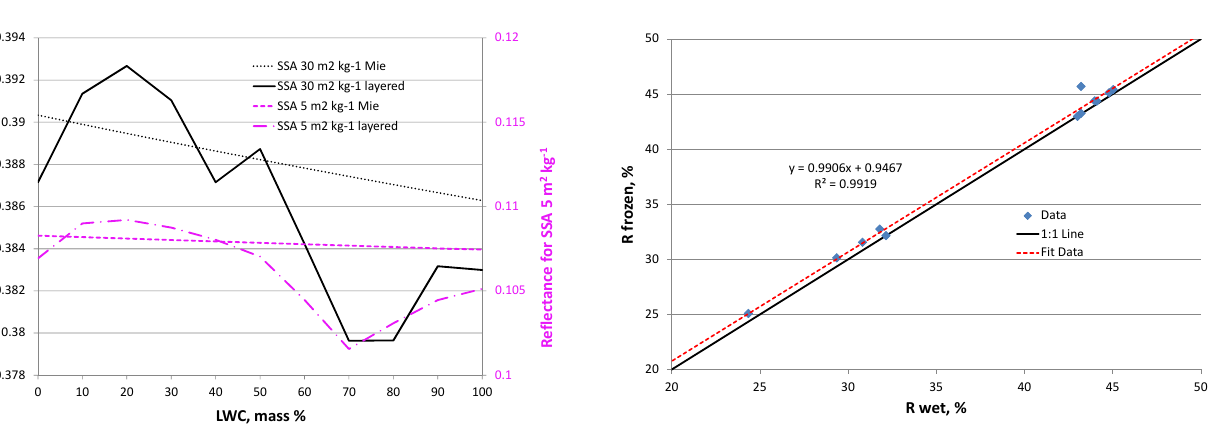
Figure 4. Correlation between the reflectances of the wet and frozen samples.